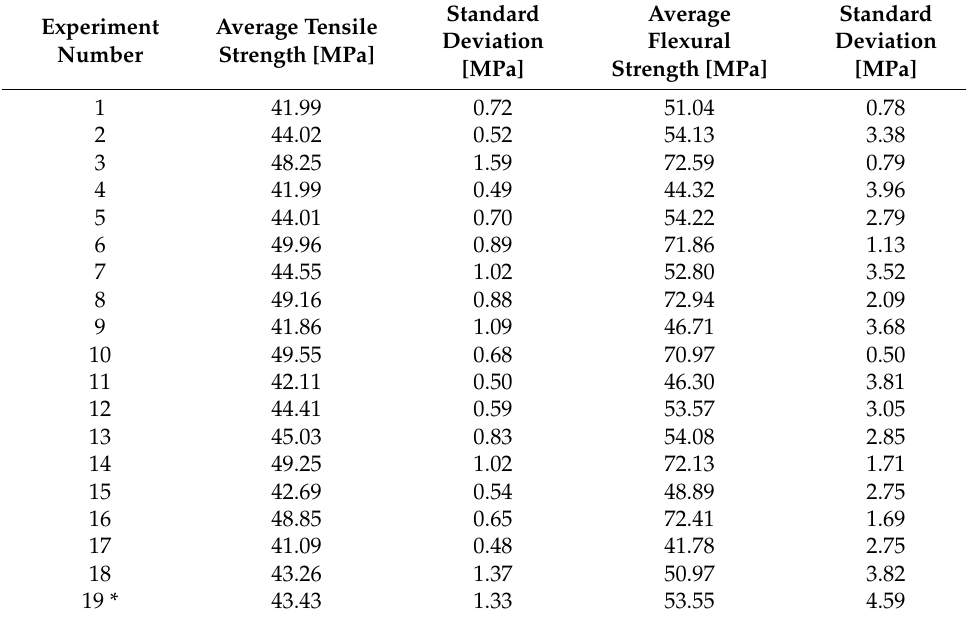
Table 4. Values of the mean maximum stresses and their standard